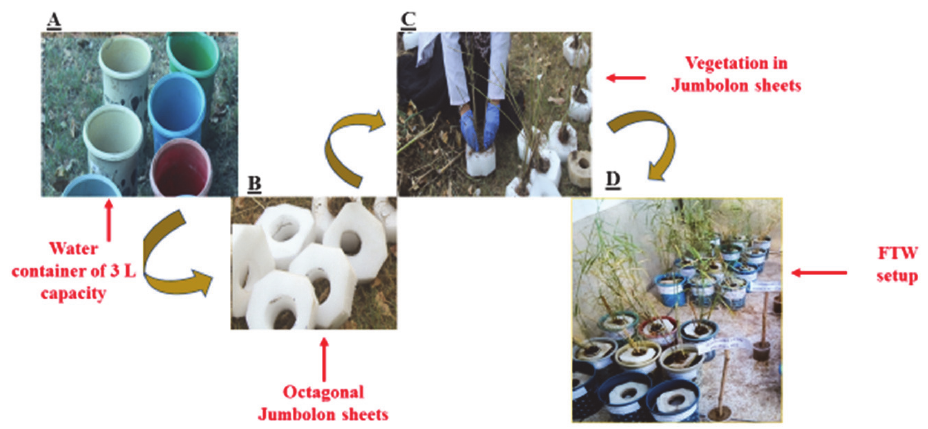
Figure 1. Development of floating treatment wetlands. Where, ( A ) shows the water containers, ( B ) shows octagonal jumbolon sheets, ( C ) shows the vegetation process, and ( D ) shows experimental setup